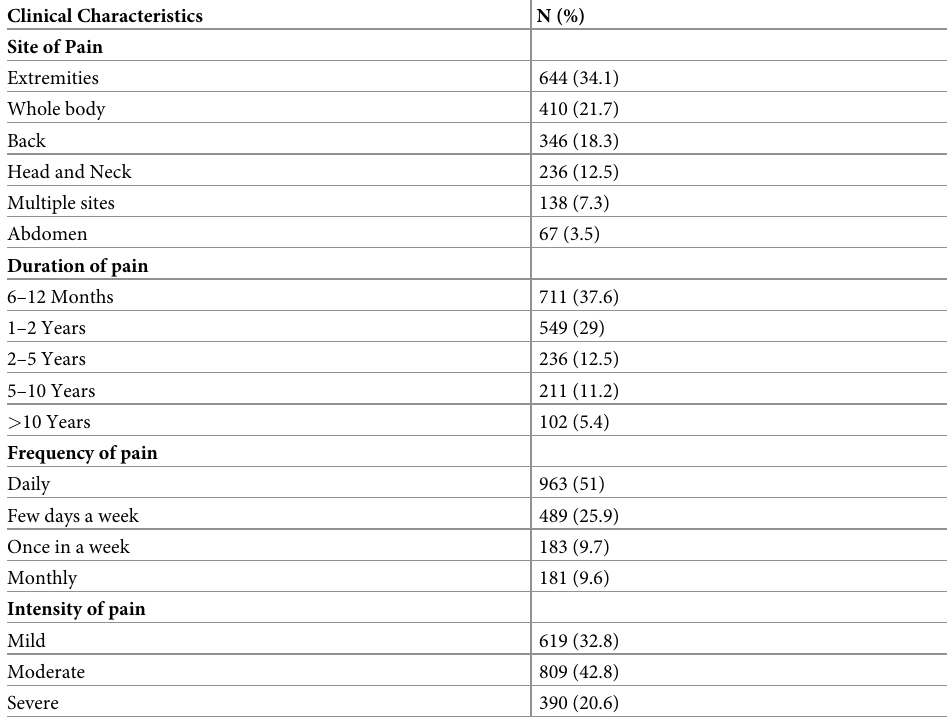
Table 1. Clinical characteristics of subjects with chronic pain (N = 1831) � . Clinical